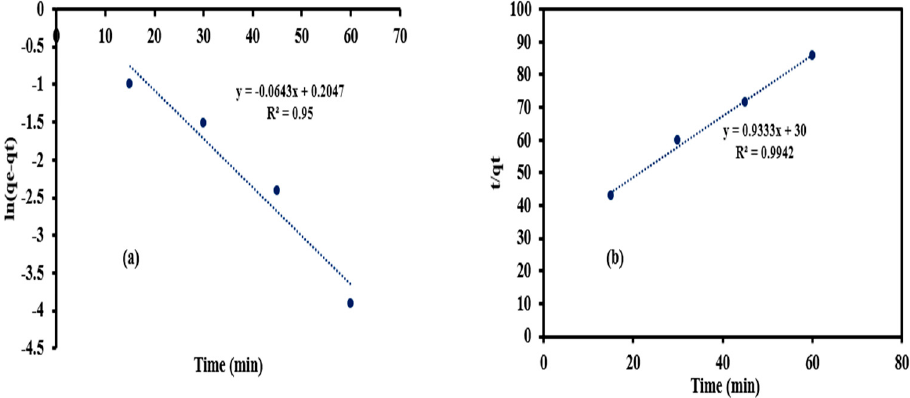
Figure 12. ( a ) Pseudo-first order and ( b ) Pseudo-second order kinetics of the adsorption of trimethoprim antibiotic on the Bio-MOF.